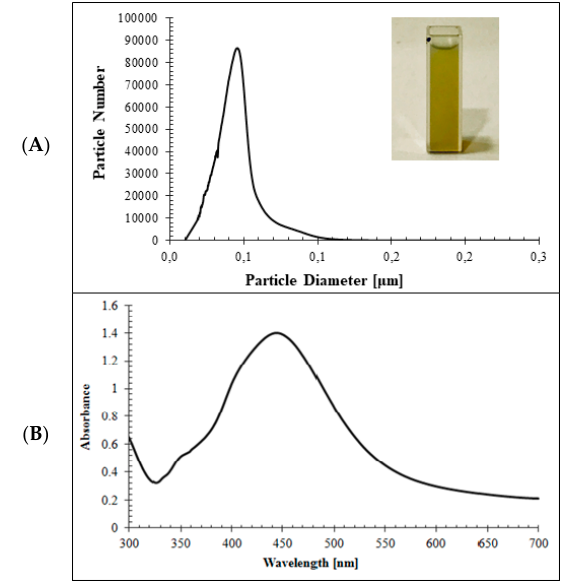
Figure 1. Characteristics of Ag-NPs: ( A ) particle number (in billions) vs. particle diameter and ( B) UV–VIS absorption